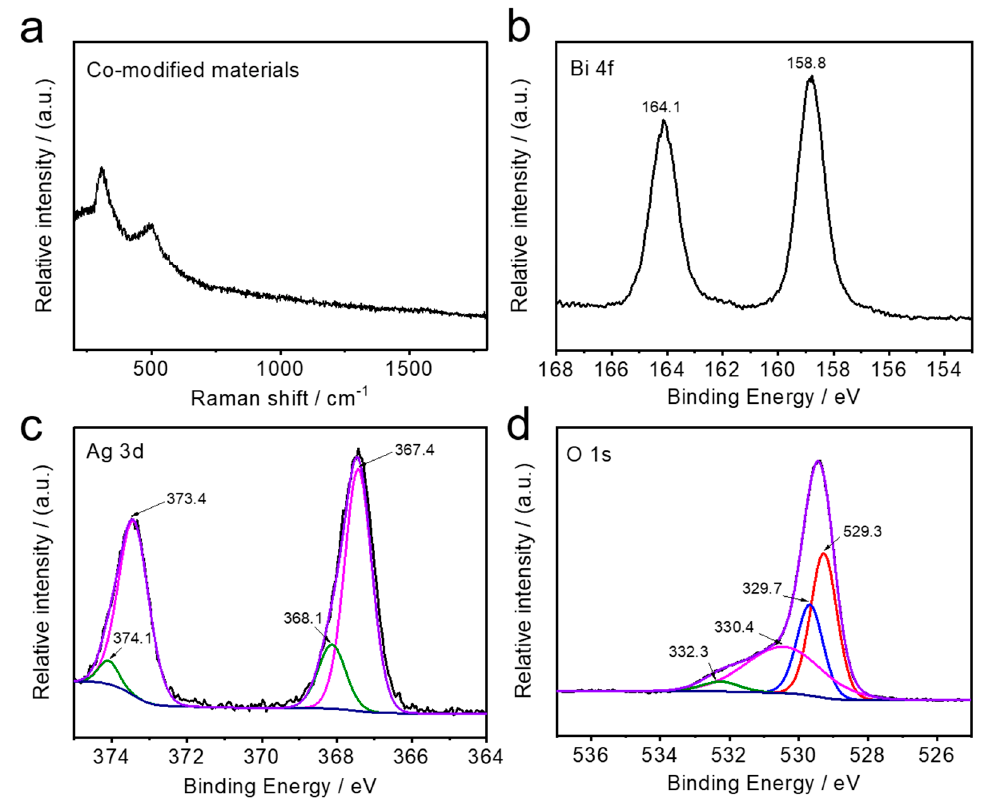
Figure 2. ( a ) Raman spectrum of the co-modified materials. XPS spectra of co-modified TiO 2 NTAs: high resolution patterns of ( b ) Bi 4f, ( c ) Ag 3d, and ( d ) O 1s.